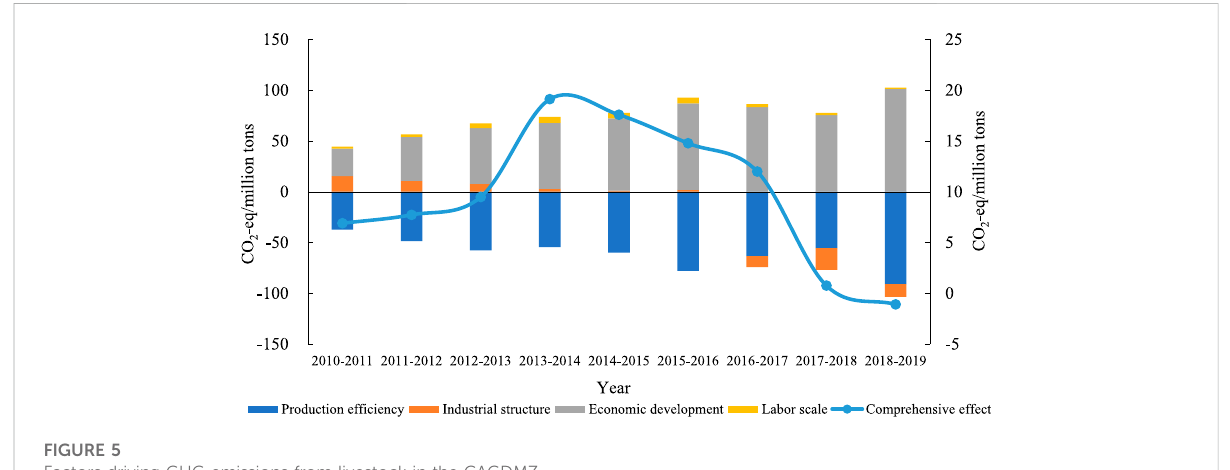
FIGURE 5 Factors driving GHG emissions from livestock in the